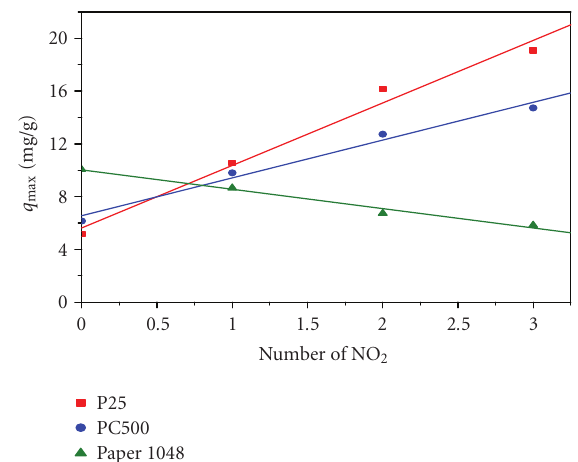
Figure 3: Linear variations between the maximum quantity of ad- sorbed polynitrophenols q max and the number of NO 2